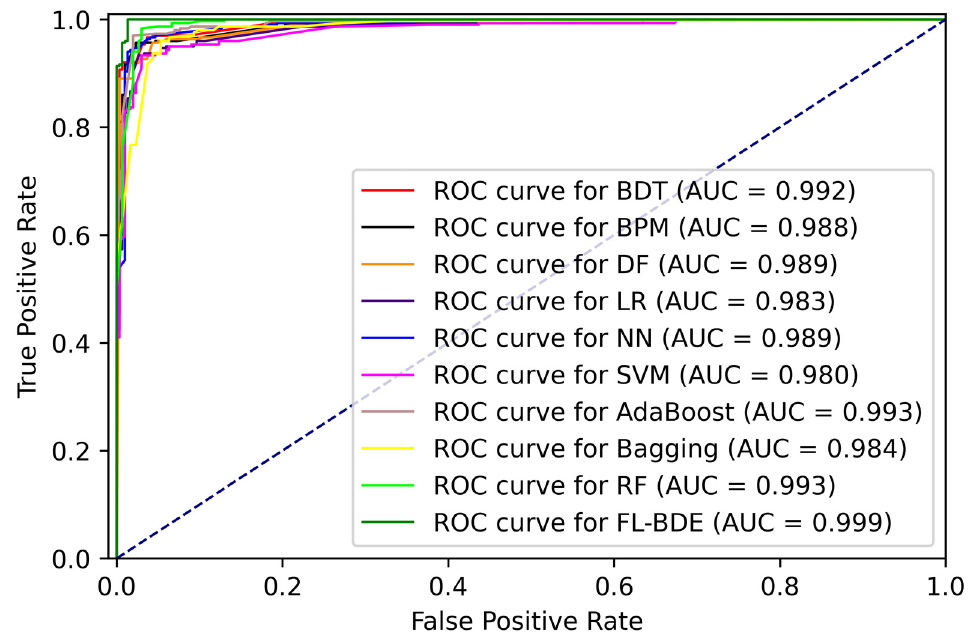
Figure 7. ROC curves of FL-BDE, ML- and EL-based models at the split ratio of 0.70.